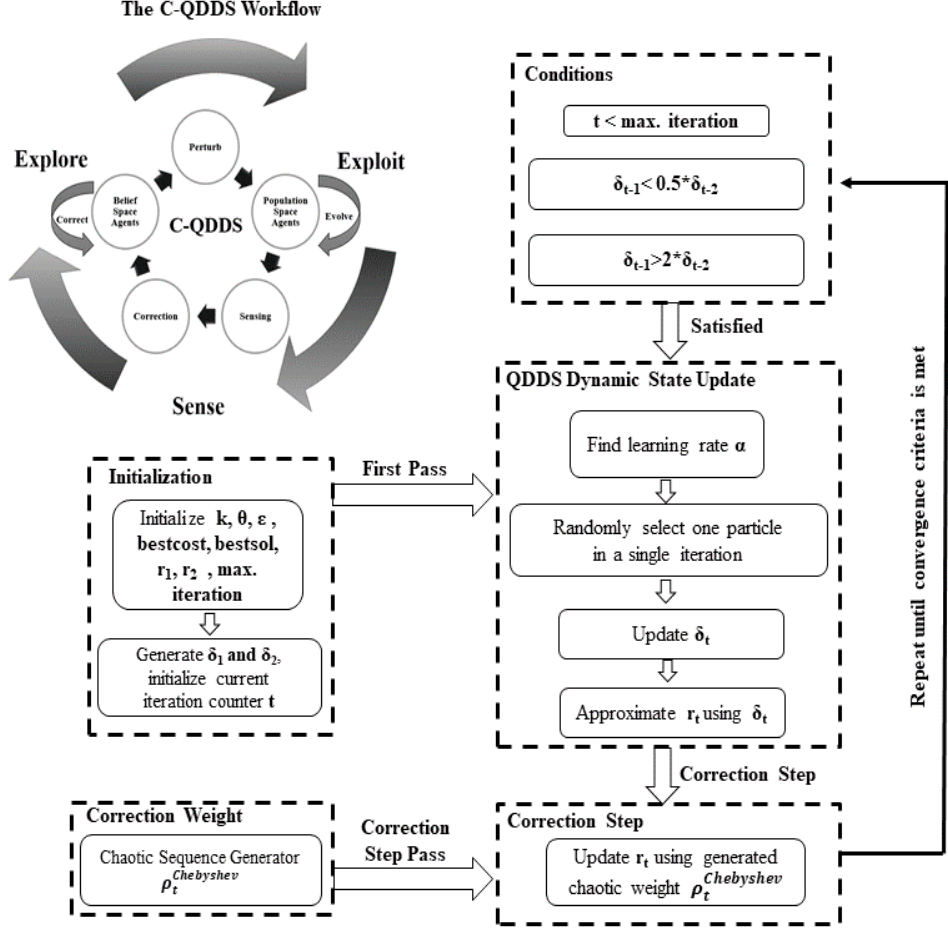
Figure 4. Schematic of the Chaotic Quantum Double Delta Swarm (C-QDDS) workflow.